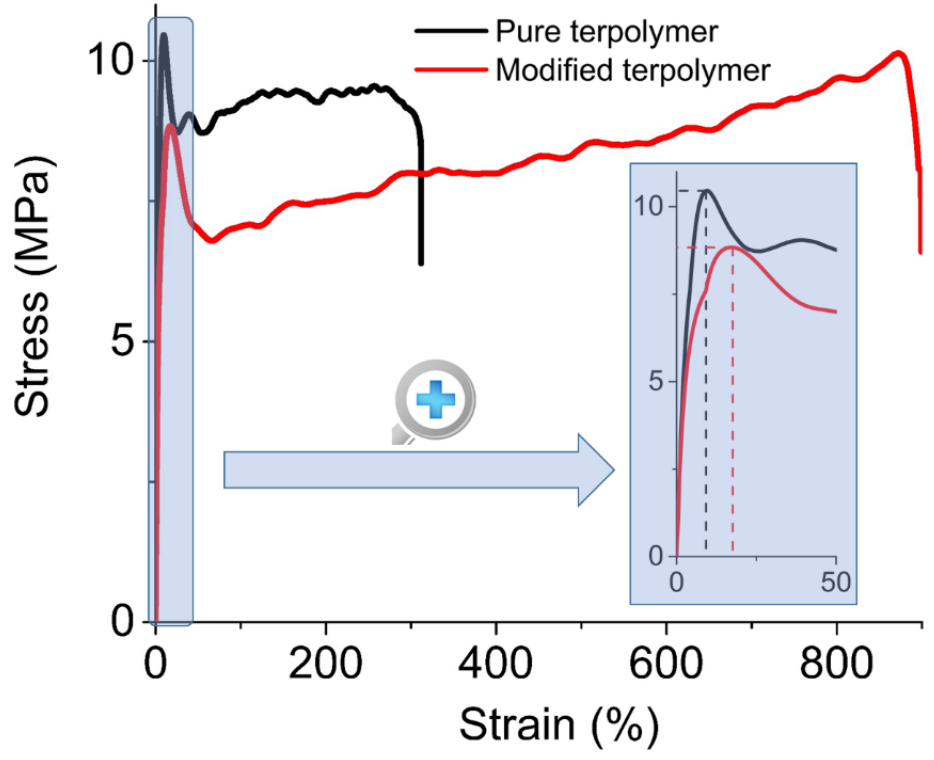
Figure 3. Stress-strain characteristics of the pure and modified terpolymers. Inset on the right-hand side is a focus on low strain.